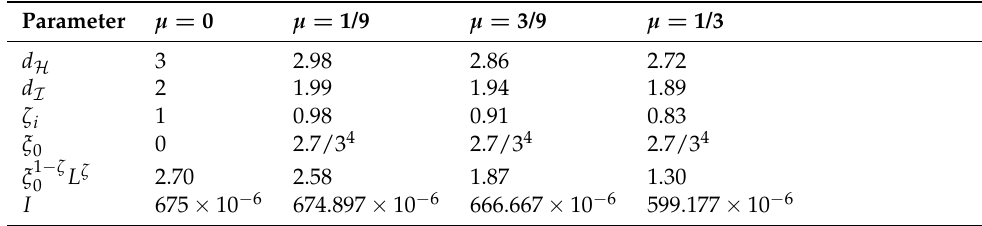
Table 1. Fractal parameters of the cantilever fractal beam.